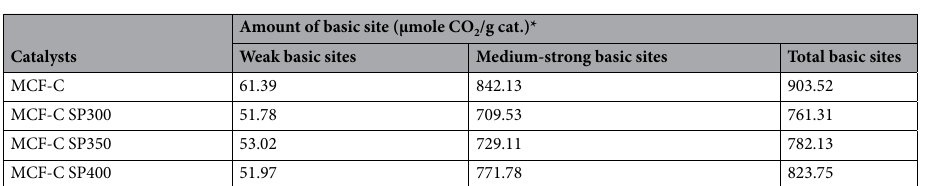
Table 4. Basicity and basic strength of all samples obtained from CO 2 -TPD. *Amounts of basic sites of catalyst were calculated by CO 2 -TPD (employ of Fityk program evaluation).